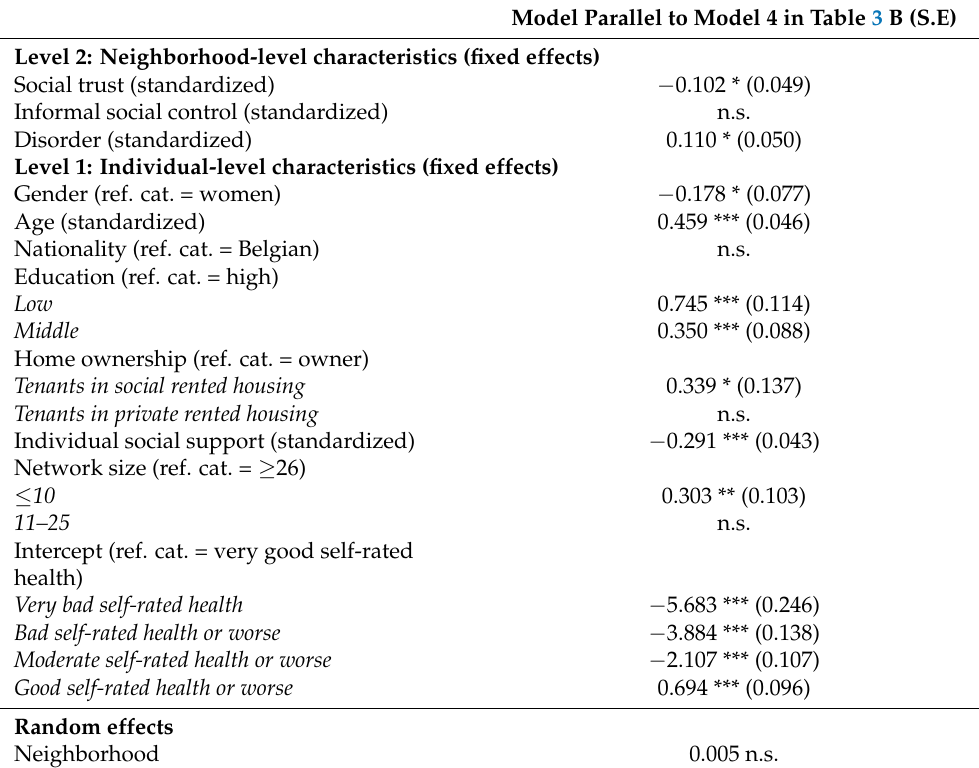
Table A2. Logistic regression coefficients (and standard errors) of a hierarchical ordered logit model (i.e., model for ordinal dependent variables, 2nd order PQL-estimation) explaining self-rated health, using ‘very good self-rated health’ as the reference category ( N =